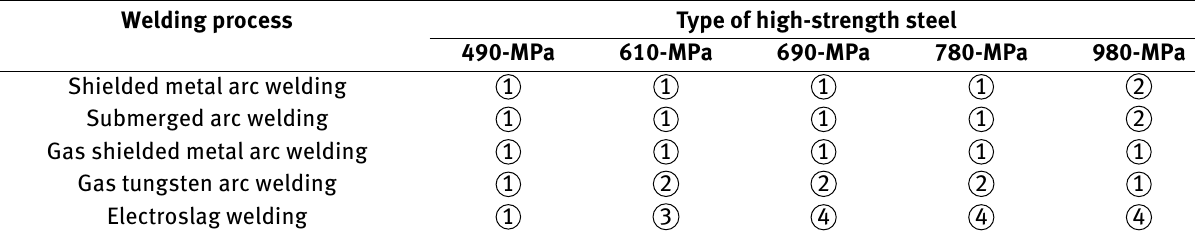
Table 3: Welding process with the type of welding consumables [28–32].